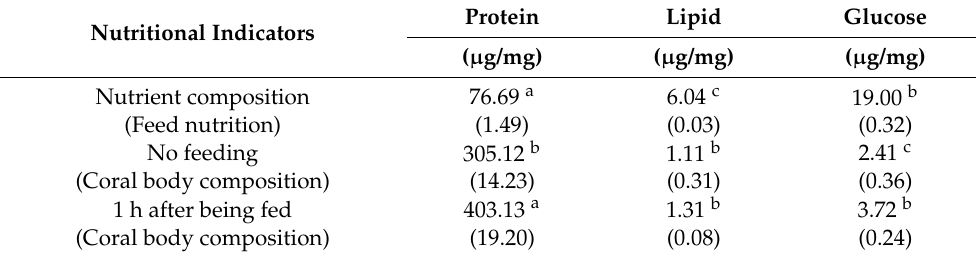
Table 2. Feed nutrition and changes in body composition 1 h after feeding of